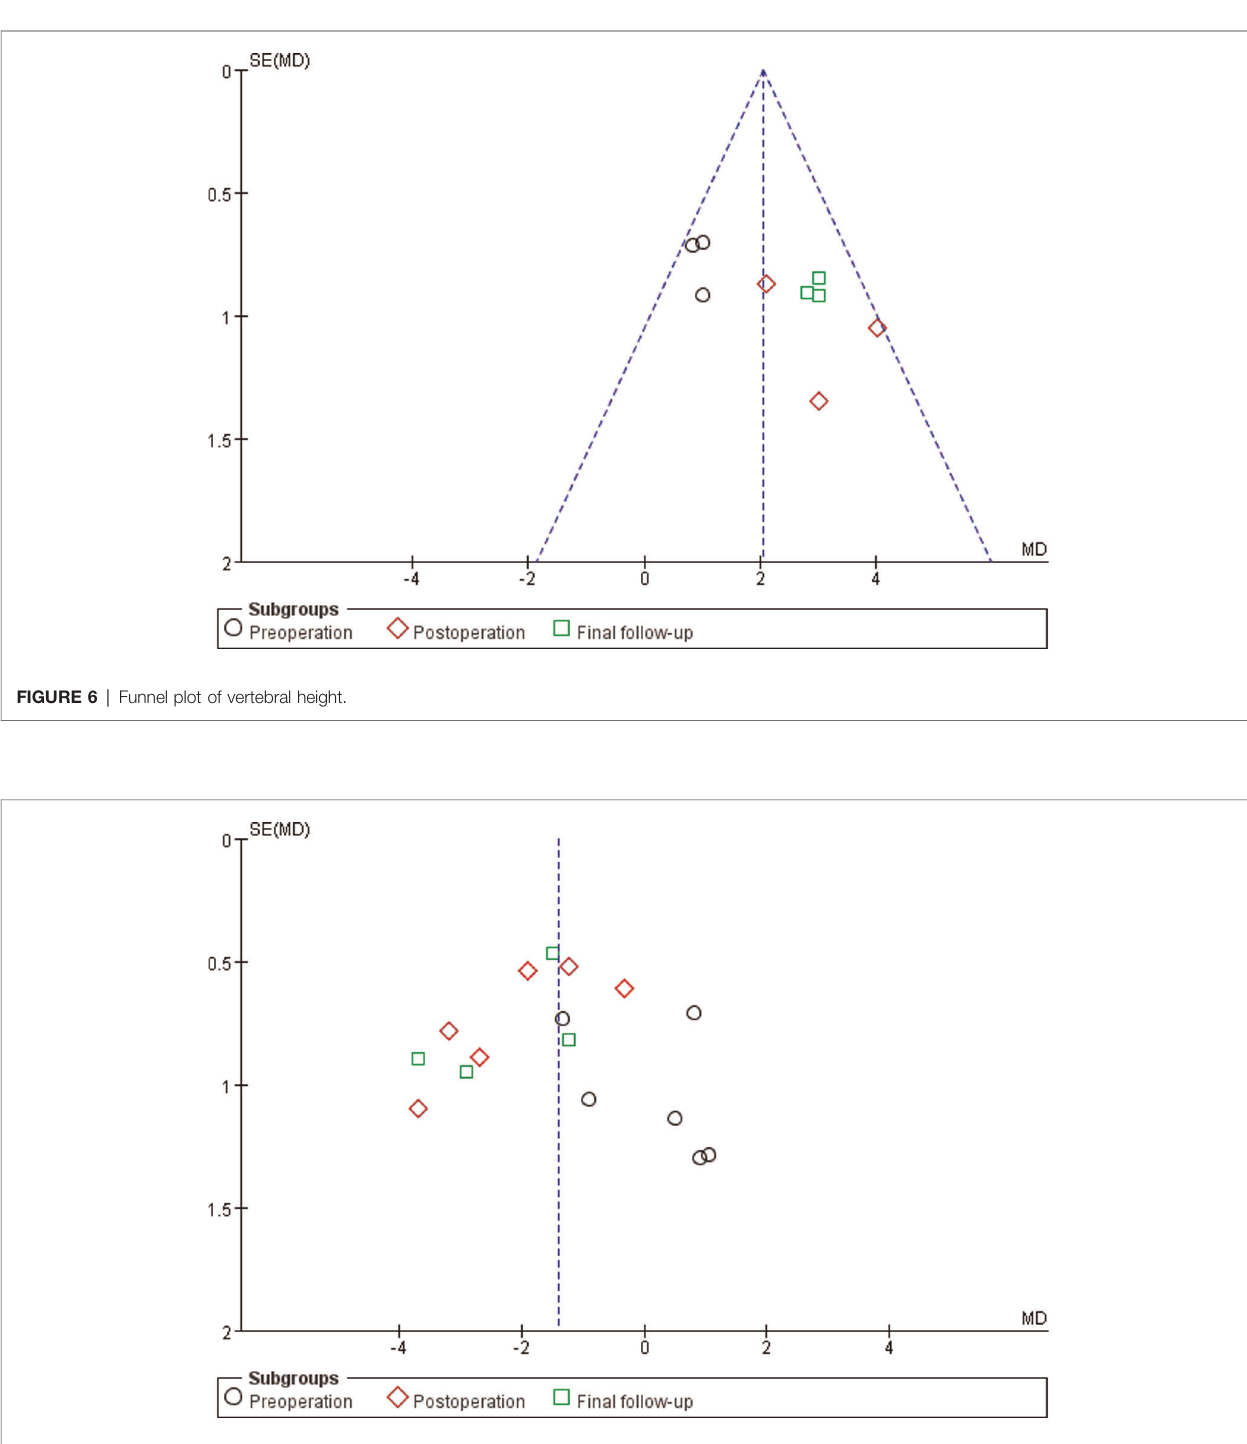
FIGURE 7 | Funnel plot of the vertebral kyphosis